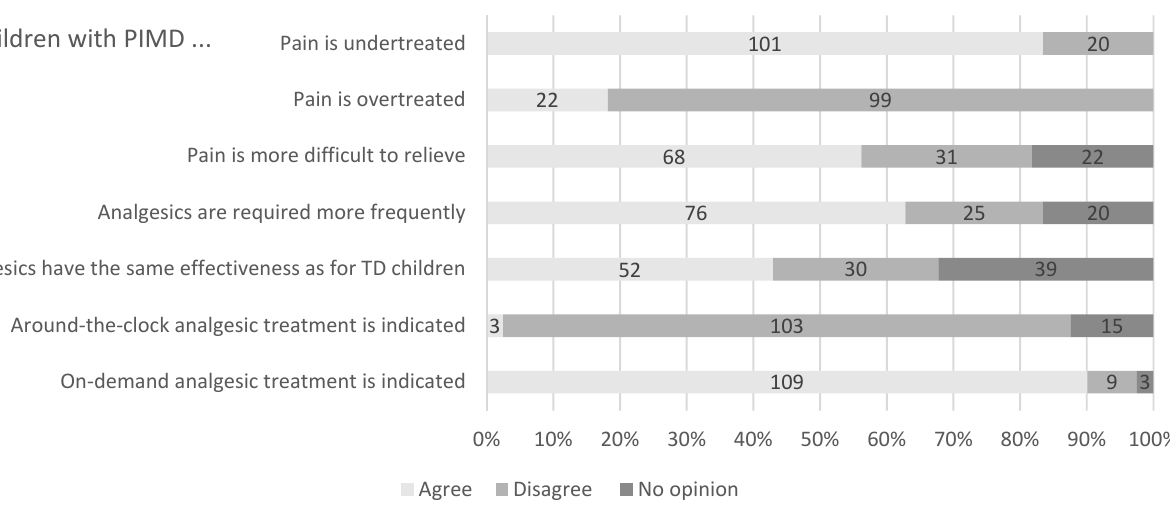
Figure 2. Paediatricians’ ( n = 121) views on pain management of children with PIMD.